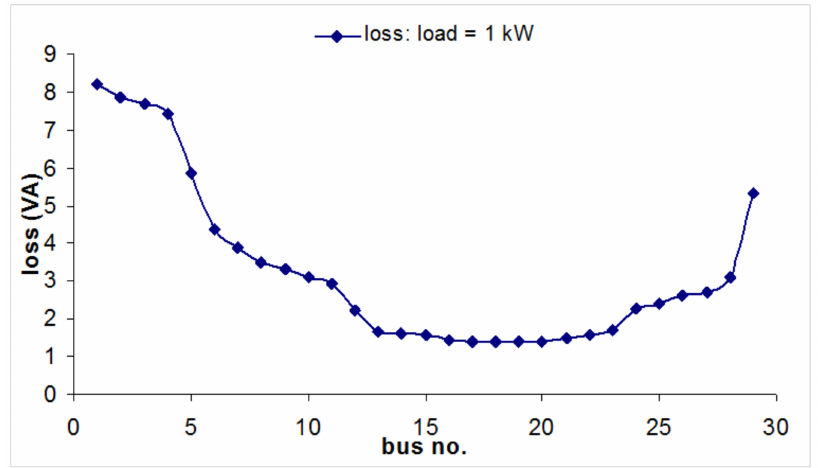
Figure 10. Variation of losses with location of PV system for a load of 1 kW.